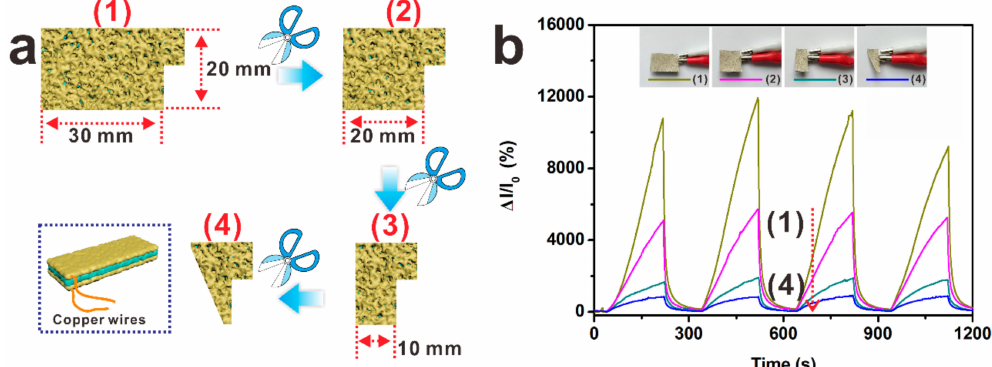
Figure 4. Free-cutting properties: ( a ) specific shapes and dimensions corresponding to ( b ). Insert: the electrodes of Ag@Fe 3 O 4 -MS can be constructed directly without silver paste and tailored to desired shapes. ( b ) Dependence of relative current on the dimensions and shapes of Ag@Fe 3 O 4 -MS at RH =